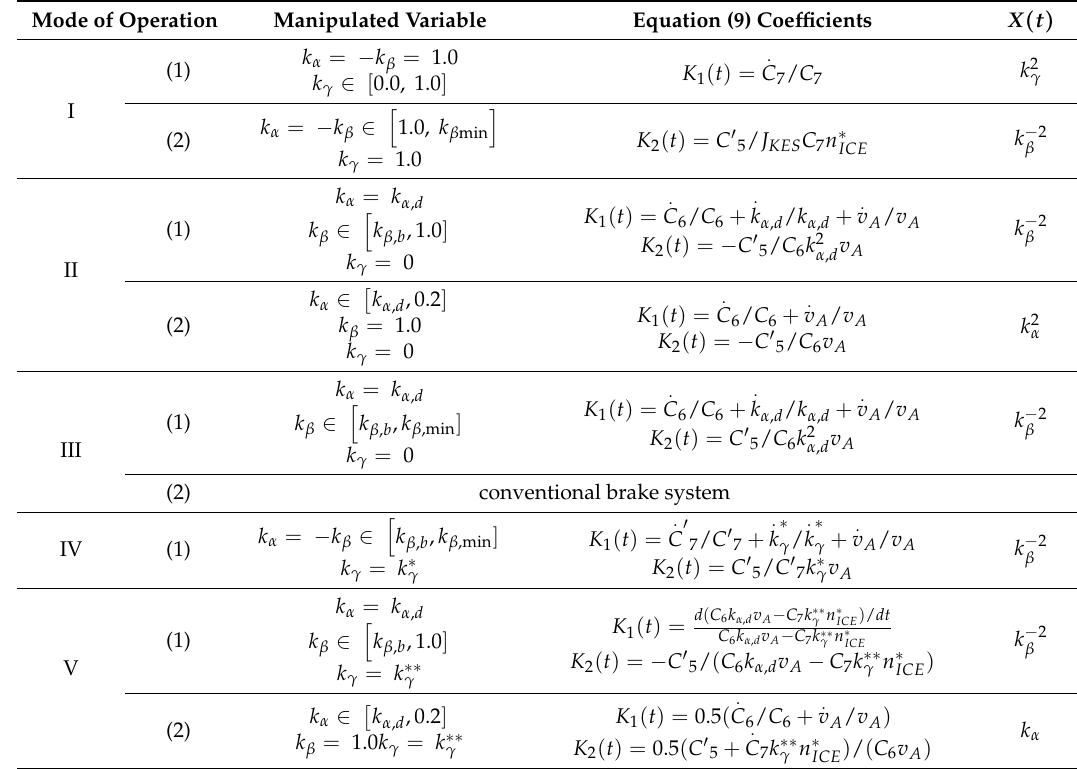
Table 2. HST control equation coefficients and unknown variable meanings at different modes of operation of the hybrid